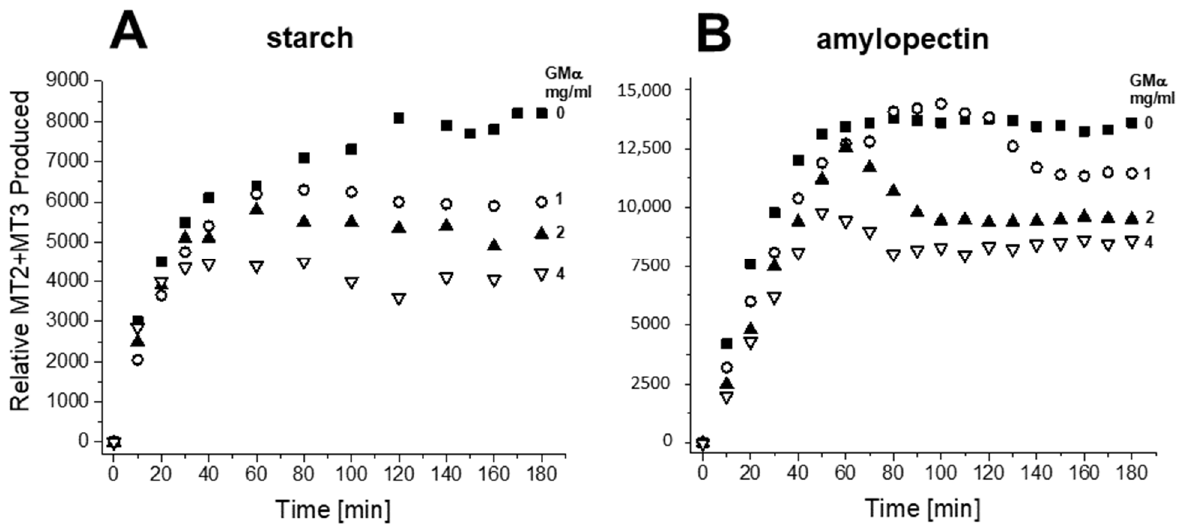
Figure 4. Using the 13 C HSQC spectra as shown in Figure 3, the peak volume integrals were determined and plotted here as the net of MT2 and MT3 as a function of the time of α -amylase- mediated (0.4 U/mL) hydrolysis of starch ( A ) and amylopectin ( B ). Data are shown for the kinetics run performed in the absence (filled squares) and presence of GM α at concentrations of 1 mg/mL (open circles), 2.1 mg/mL (filled triangles), and 4.2 mg/mL (inverted open triangles). Solution conditions are 20 mM potassium phosphate, pH 7, 30 °C.